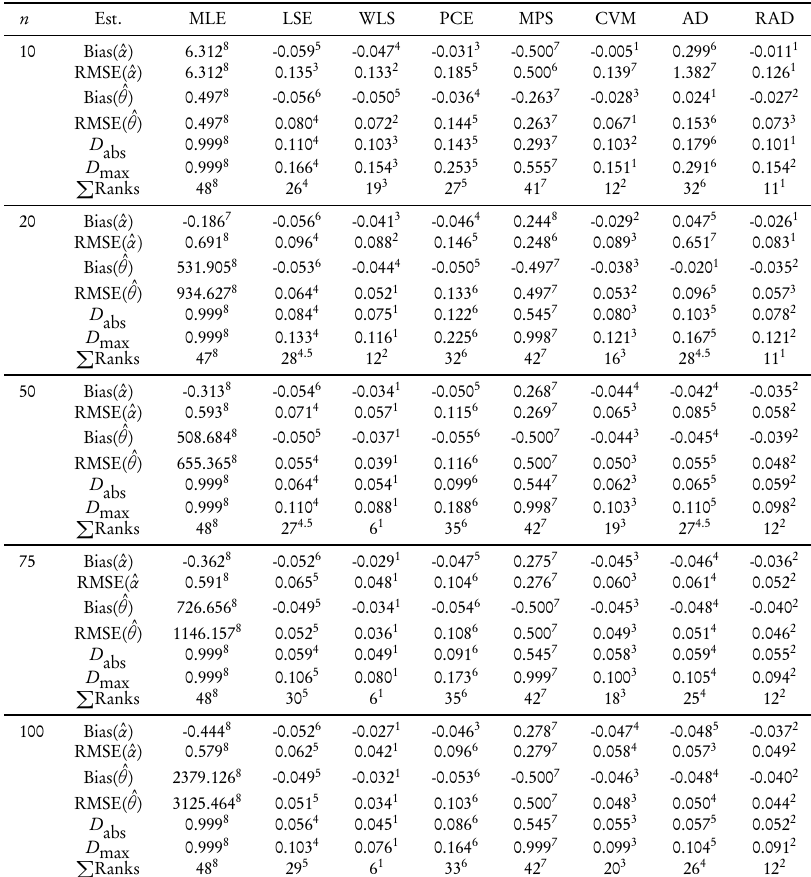
Simulation results for α = 0.5 , θ = 0.5 and λ = 1